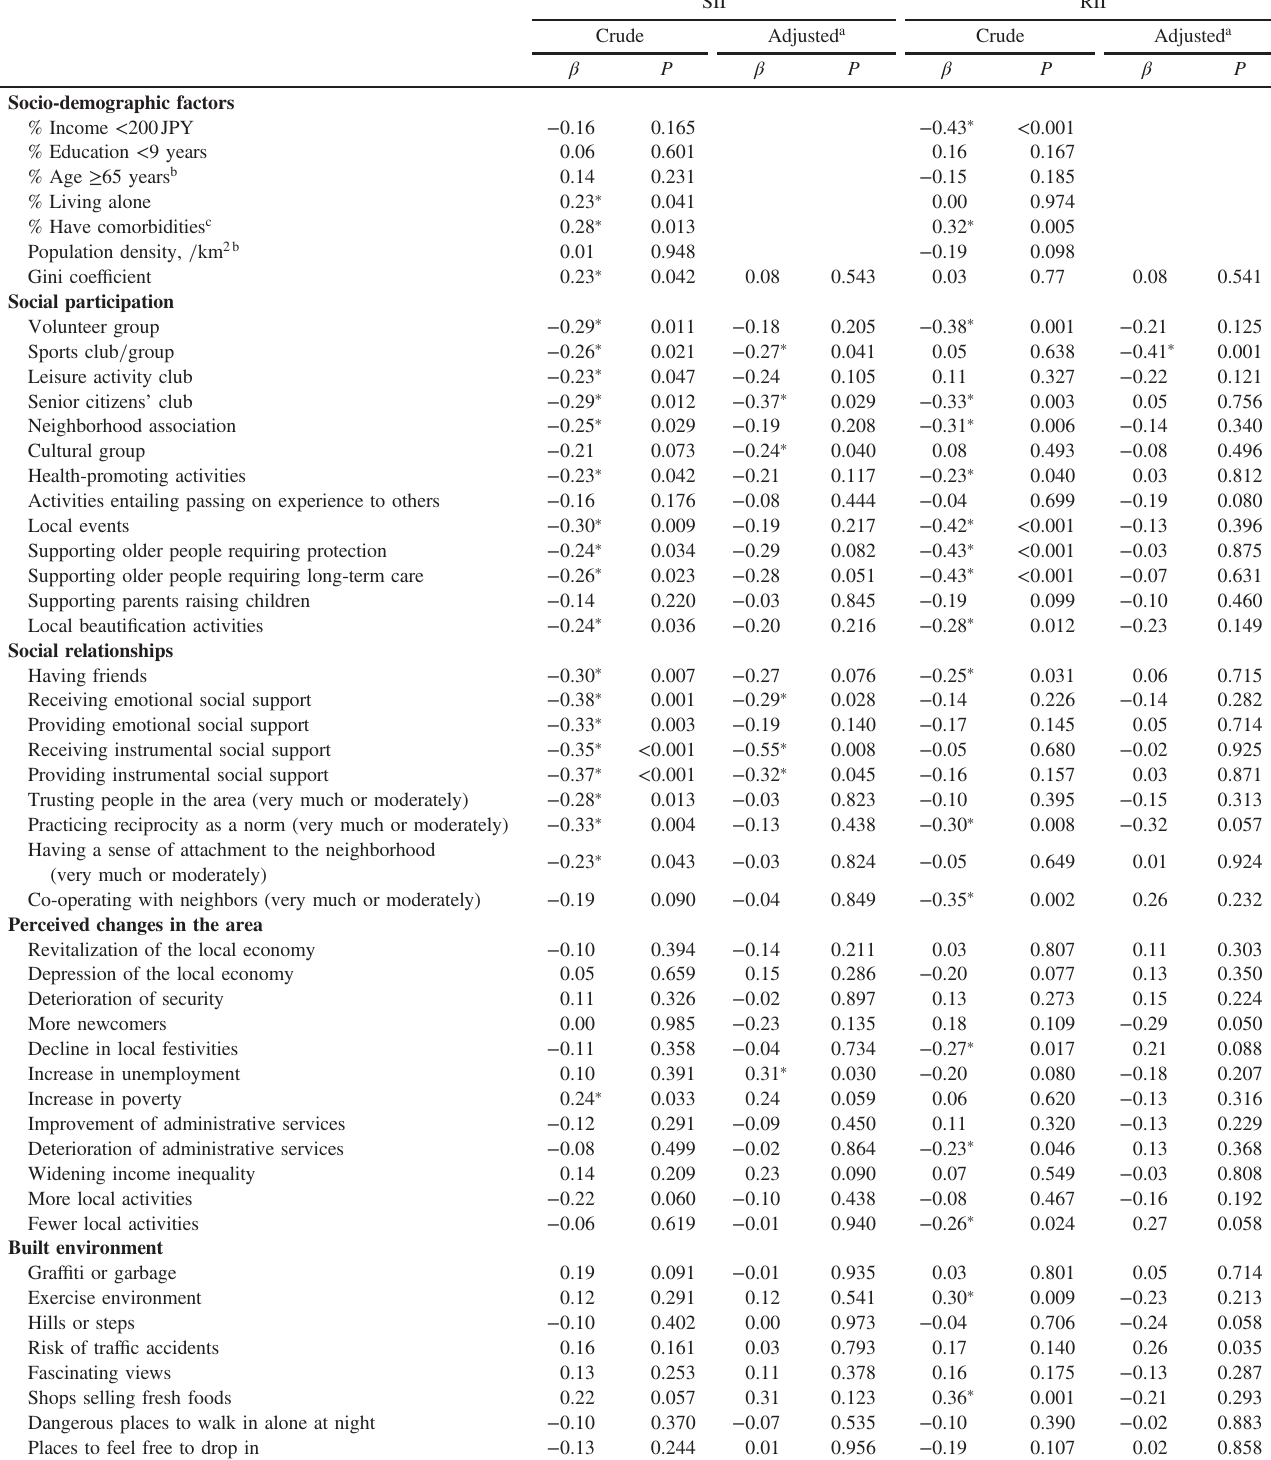
Table 3. Association between income-based health inequality indices (slope index of inequality [SII] and relative index of inequality [RII]) in depressive symptoms by a unit increase of 1 standard deviation in measures of community characteristics among older Japanese men ( n = 51,962): multiple regression